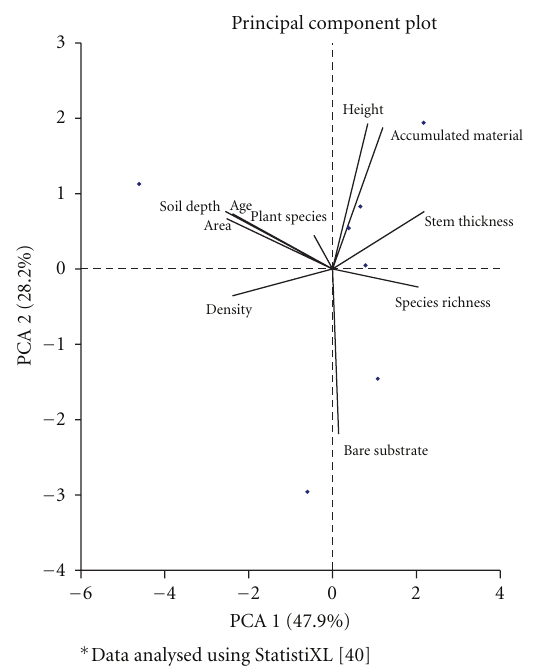
Figure 4: PCA ∗ of Species Richness against all other Site- Specific Variables. From this PCA analysis of species richness of invertebrates across all reed-bed sites, only bare substrate was found to be positively correlated, whilst age, area, soil depth, and plant species richness were found to be negatively correlated. All other variables measured did not a ff ect species richness.